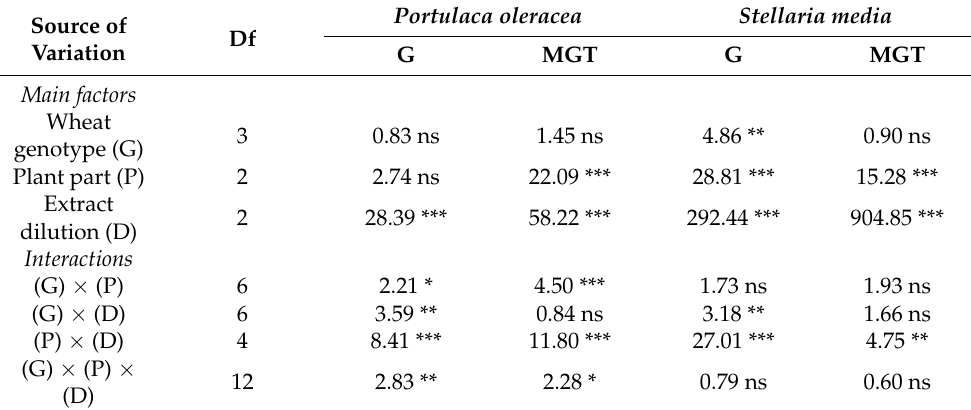
Table 1. F -Fisher values of main factors and their interactions resulting from analysis of variance (ANOVA) on final seed germination percentage (G) and mean germination time